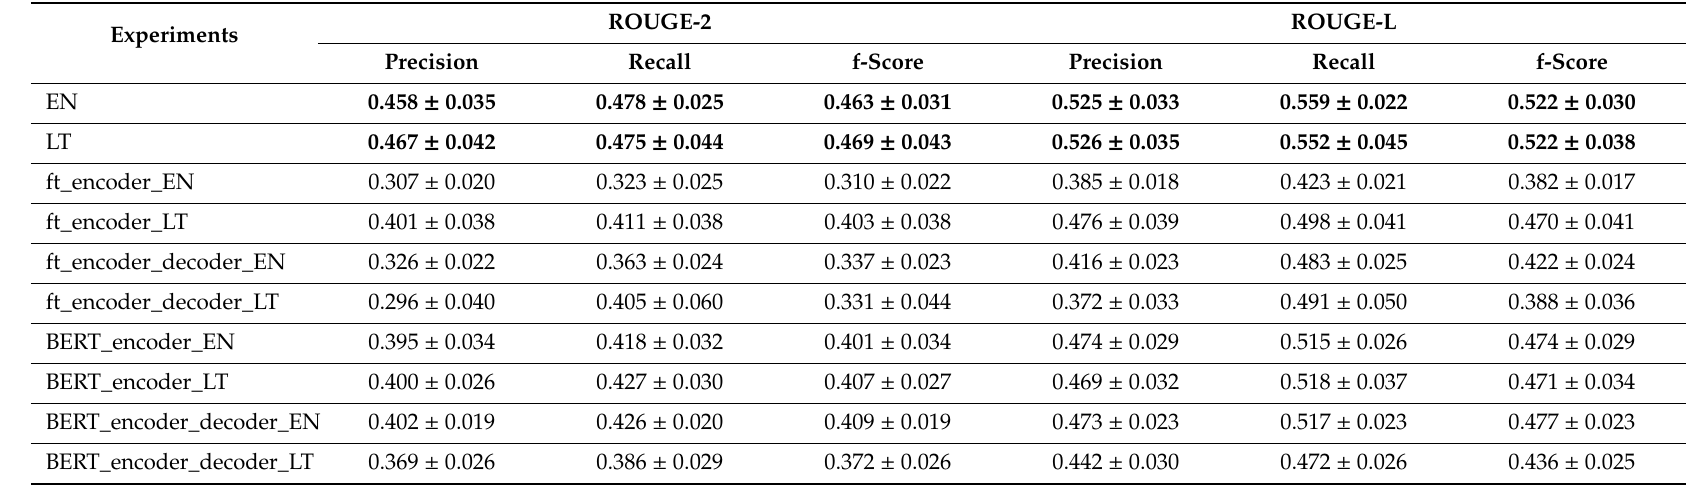
Table 2. Averaged Recall-Oriented Understudy for Gisting Evaluation (ROUGE)-2 and ROUGE-L precision / recall / f-score values with confidence intervals using the LSTM encoder and decoder model with di ff erent vectorization types on the dataset with removed punctuation. The best values in the column for EN and LT are in bold. BERT—Bidirectional Encoder Representations from Transformers;